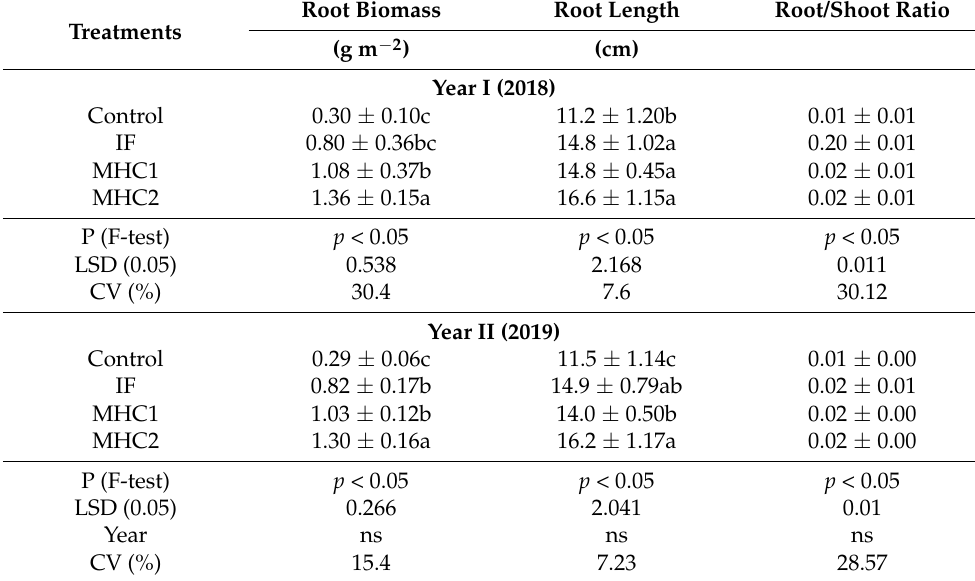
Values are means ± standard deviation; n= 12; within a column means bearing the same letter are not statistically different; Control = no fertilizer; IF = 100:60:60 kg NPK ha − 1 ; MHC1 = Macadamia husk compost at 15 t ha − 1 ; MHC2 = Macadamia husk compost at 30 t ha − 1